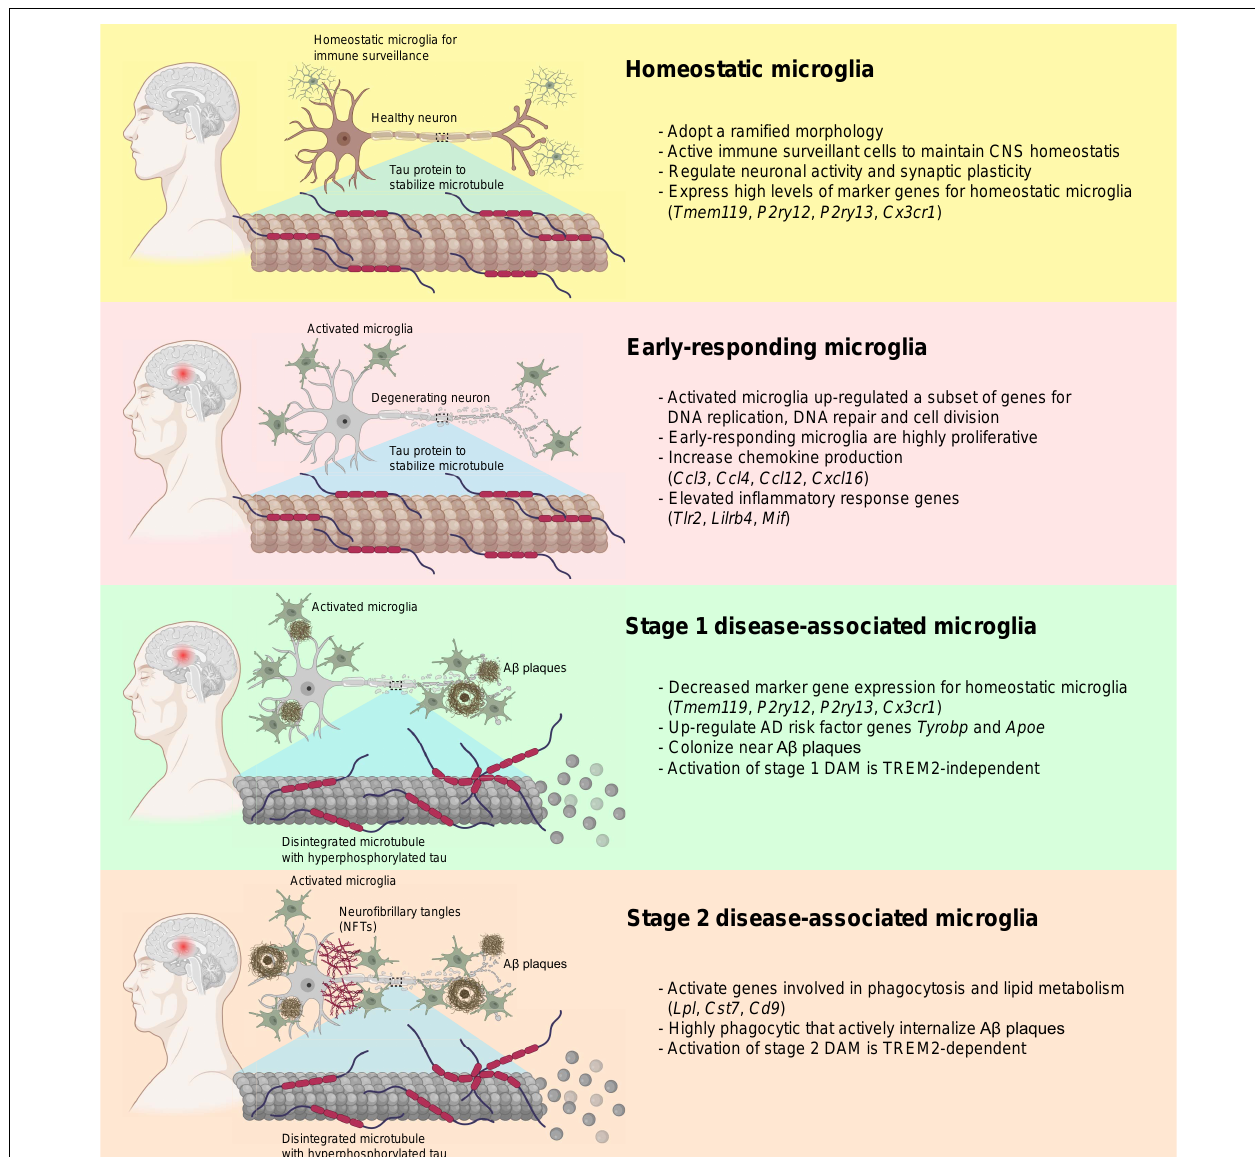
FIGURE 3 | Disease-associated microglia (DAM) and their transformation during the pathogenesis of AD. In healthy individuals, microglia usually adopt a ramified morphology and expressed a diverse variety of marker genes for homeostatic microglia. In the early pathogenesis of AD that preceded the deposition of A β plaques and neurofibrillary tangles (NFTs), the homeostatic microglia transformed into a highly proliferative state and elevated the production of various chemokines and other inflammatory genes. When A β plaque loads gradually increased, some of the microglia down-regulated the expression of the homeostatic microglial marker genes, transformed into stage 1 DAM with elevated expression of Tyrobp and Apoe via TREM2-independent pathways, and started colonizing near the A β plaques. With the increase in A β and NFT deposition, the stage 1 DAM slowly transformed into fully activated stage 2 DAM via TREM2-dependent pathways. These stage 2 DAM were highly phagocytic and involved in the active internalization of A β plaques via activation of genes involved in phagocytosis and lipid metabolisms. Publishing license from BioRender.com.